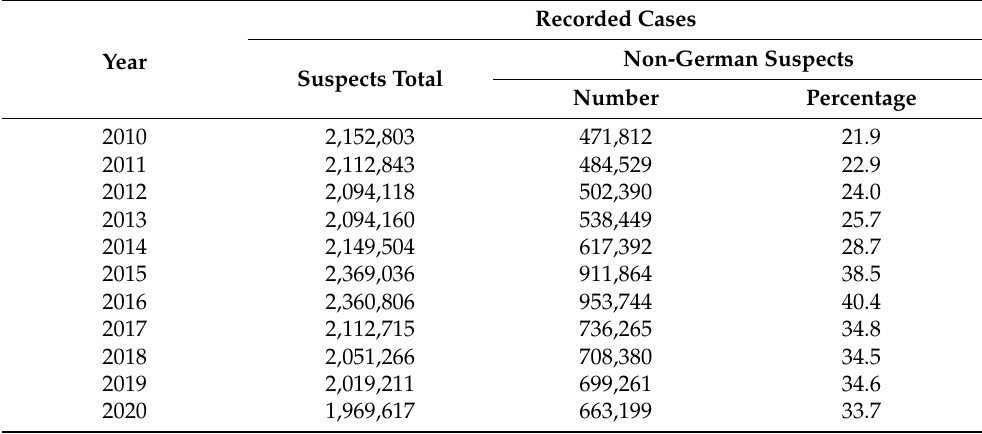
Table 3. Recorded cases by BKA (2010–2020). Source from BKA, Police Crime Statistics (Police Crime Statistics n.d.), table made by authors.